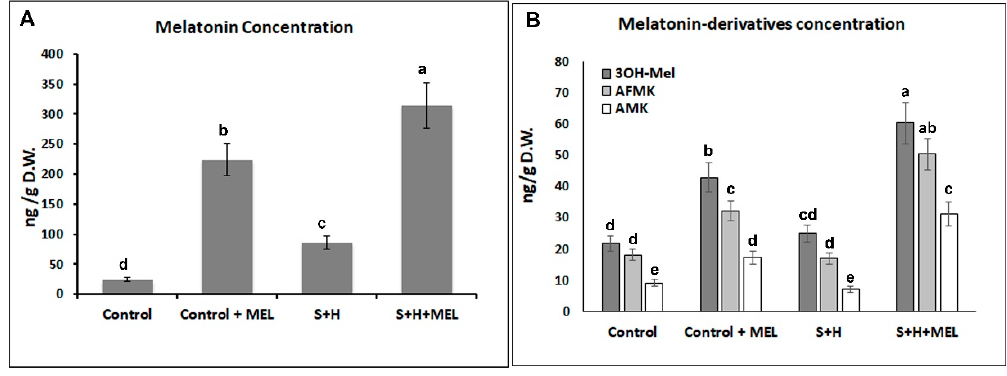
Figure 2. ( A ) Melatonin concentration and ( B ) Melatonin-derivatives: 3-hydroxymelatonin (3OH-Mel), N 1 -acetyl -N 2 -formyl-5-methoxykymuramine (AFMK) and N 1 -acetyl-5-methoxykynuramine (AMK) obtained from tomato leaves grown under control conditions or stress combination (salinity and heat, S + H) with (+MEL) or without melatonin pre-treatment. Values represent means ± SE ( n = 6). Bars with different letters within each panel are significantly different at p > 0.05 according to Tukey’s test.